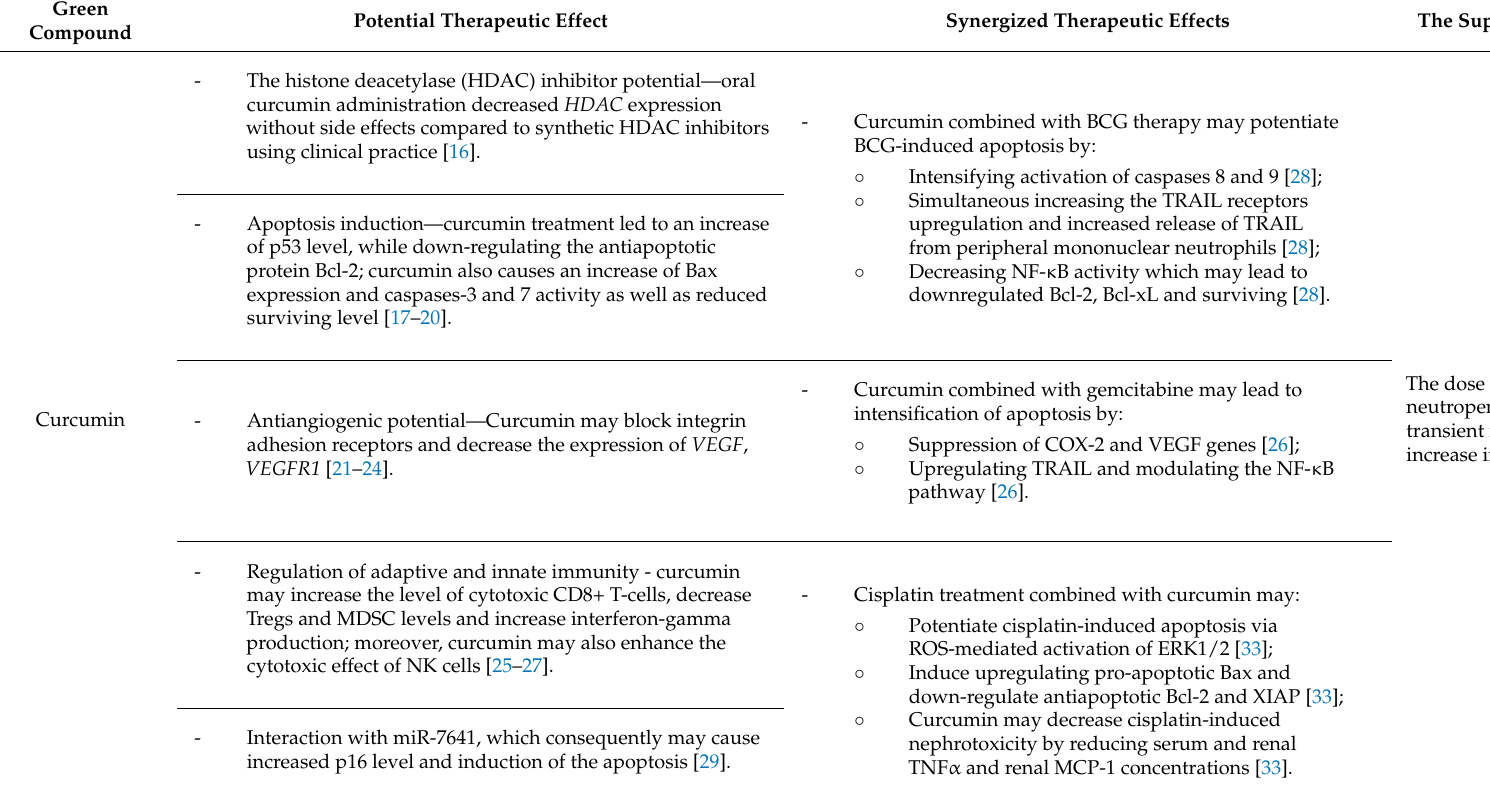
Table 1. The anticancer potential of the analyzed green compounds in BC